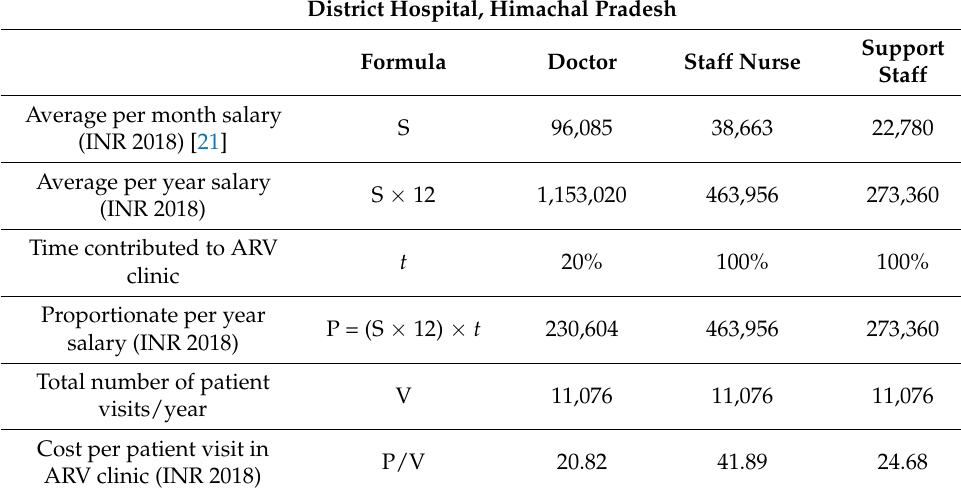
Table A9. Cost per patient visit in ARV